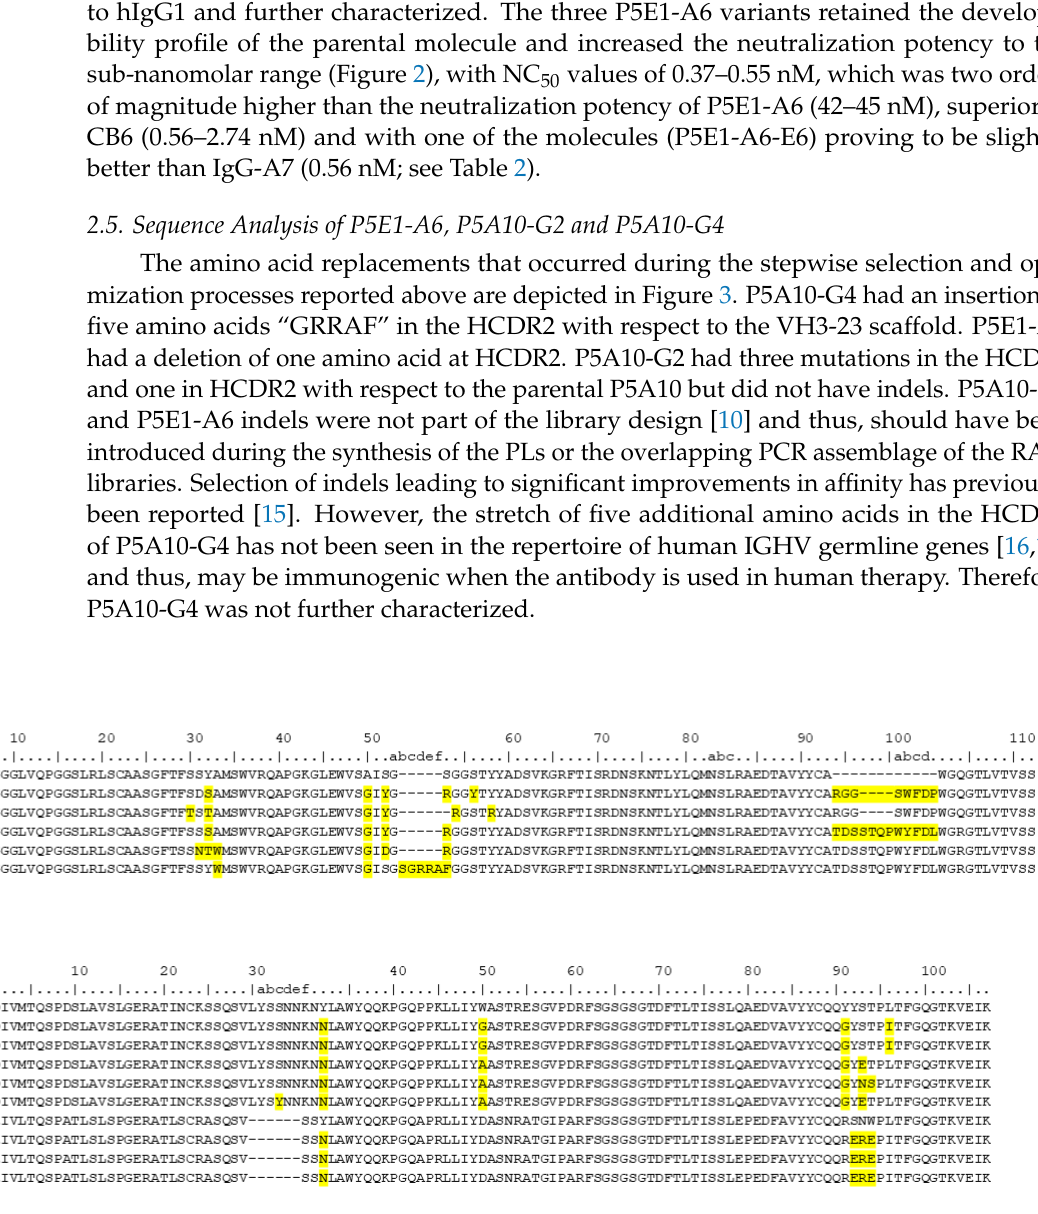
Figure 3. Alignment of the amino acid sequences of parental molecules (P5E1 and P5A10), VH RAM optimized (P5E1-A6, P5A10-G2 and P5A10-G4) and the final VL RAM optimized molecules (P5E1- A6-A4, P5E1-A6-E2 and P5E1-A6-E6). The second column corresponds to the VH or VL scaffolds. The mutations with respect to the VH scaffolds are highlighted in yellow. Numbering on top of the sequences followed the conventions of Chothia et al. [18].